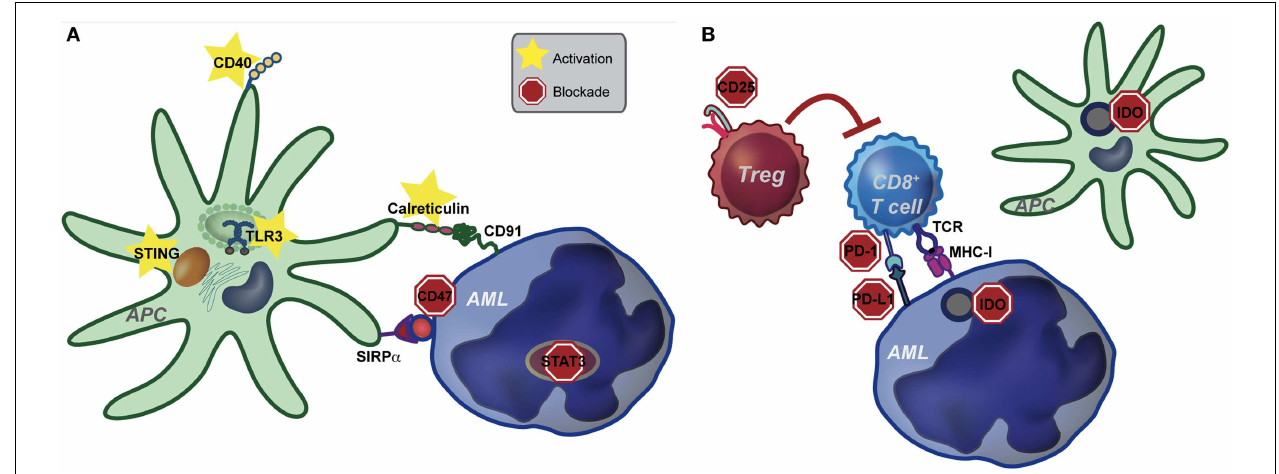
FIGURE 1 | Pathways of potential immune targeting inAML . (A) Innate immunity may be targeted in AML through activation of the STING,TLR (specificallyTLR-3) and CD40 receptors. Strategies to enhance calreticulin exposure on AML cells, combined with CD47-blocking antibodies may also be effective. Lastly, STAT3 signaling appears to inhibit the innate immune response, including hampering the effect ofTLR9, and inhibition of STAT3 signaling in AML cells leads to differentiation to antigen presenting cells (APCs) with an activated DC phenotype. Activation of the innate